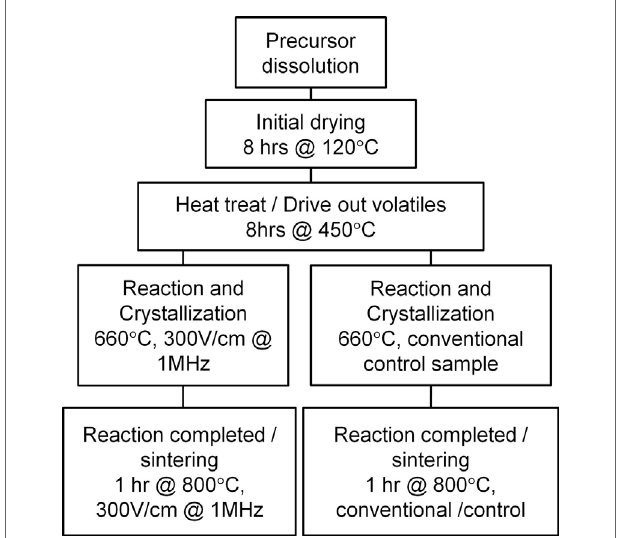
FigUre 3 | sintering schedule and displacement (volume change) during the crystallization process . FigUre 2 | sample processing flowchart